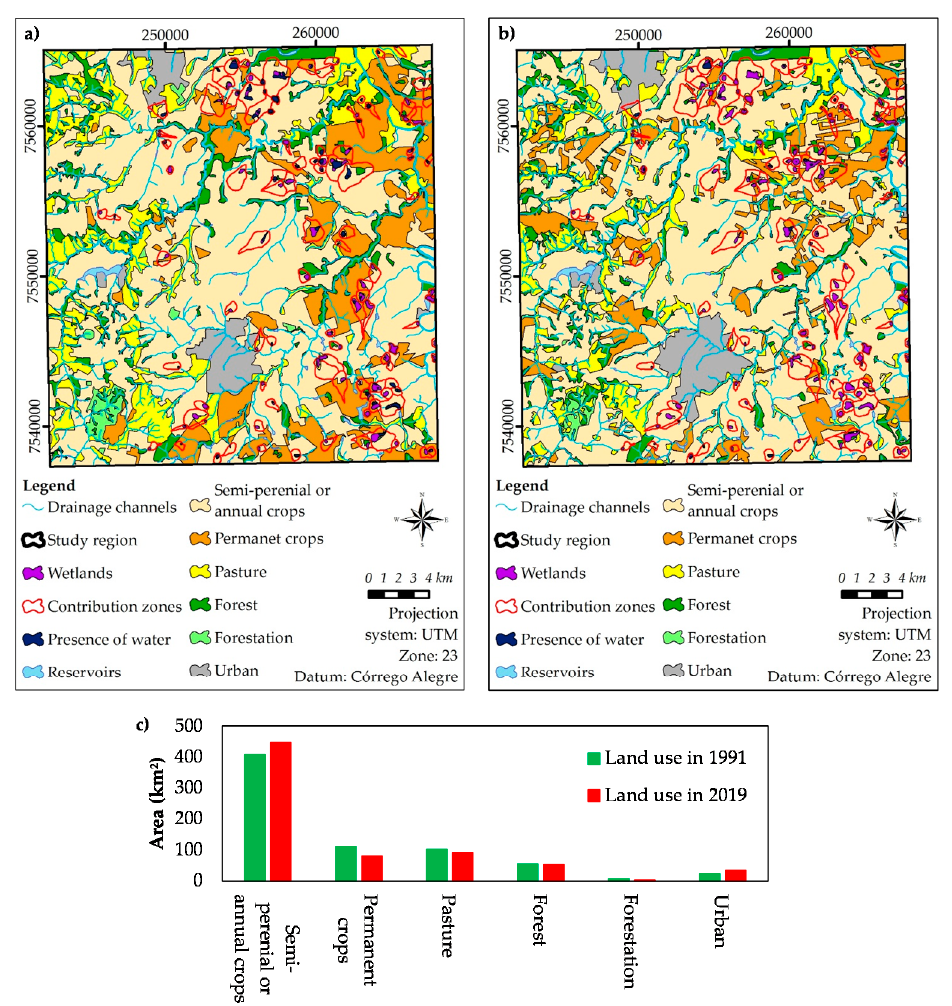
Figure 10. Land use maps for ( a ) March 1991 and ( b ) March 2019, and ( c ) is the total area of each land use in both years.